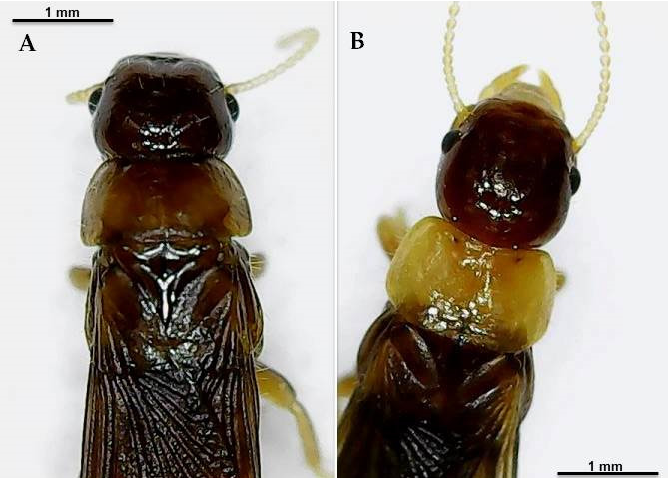
Figure 2. Alate individuals of Kalotermes sp. ( A ) Alate probably belonging to Kalotermes italicus sp. nov. contained in jar II. ( B ) Alate of Kalotermes flavicollis contained in jar 6, tube V6-P06.7 .